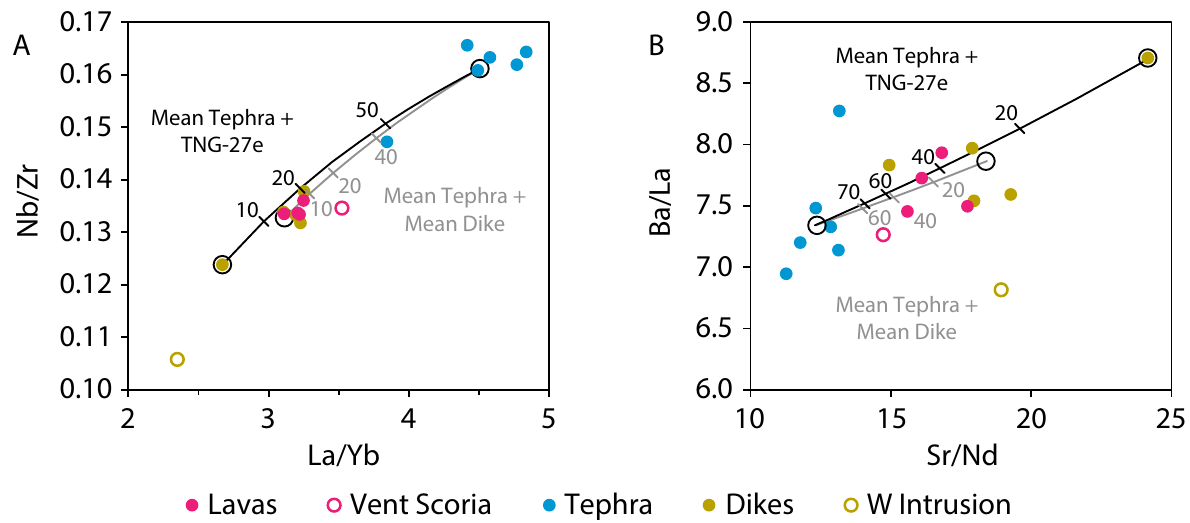
Figure 14: Trace element mixing curves between the mean tephra composition and two possible end members for the ascending magma—the chilled margin of the dike (TNG-27e) and the mean composition of the dike (which excludes the western wall intrusion). Estimates for the proportion of tephra in the erupted lavas varies greatly between different trace elements. Some more refractory elements (Nb/Zr vs La/Yb) yield lower estimates of 10–20 % tephra [A] while other lithophile elements (Ba/La vs Sr/Nd) yield higher estimates of 40–70 % tephra for some samples [B]. These large and nonsystematic differences suggest that other processes besides tephra incorporation into the magma must explain variation in Thríhnúkagígur